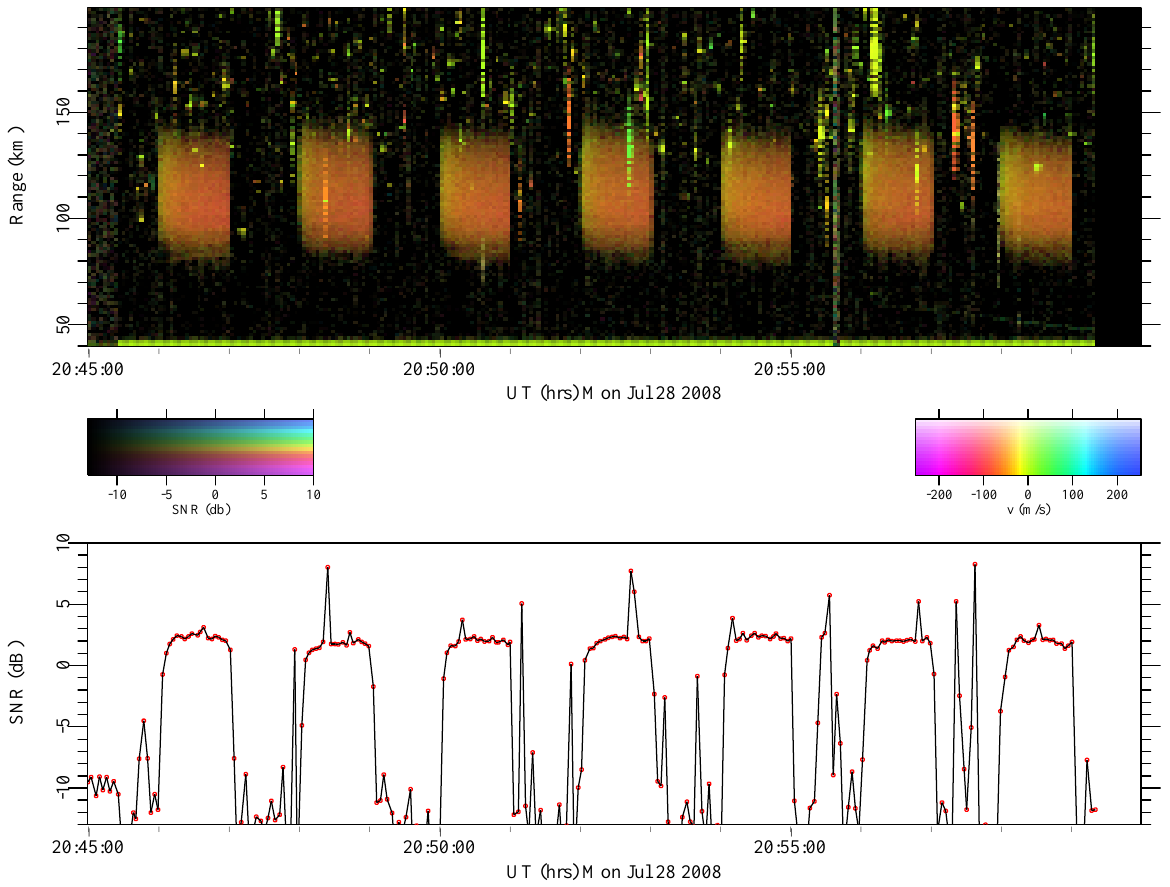
Fig. 1. Range-time Doppler intensity (RTDI) plot of backscatter from artificial E region FAIs over HAARP observed on 28 July 2008. Here, the brightness, hue, and saturation of the pixels denote echo signal-to-noise ratio (SNR), Doppler shift, and spectral width. Note that the echoes from heater-induced FAIs are range aliased and that their true range is greater than their apparent range by 370 km. The average signal-to-noise ratio for apparent ranges between 80–140 km is plotted beneath the RTDI plot. Echoes from meteor trails are also visible in the figure. The incoherent integration time for the figure is about 3 s. Note that specular and long-lived meteor echoes are also visible throughout the figure.